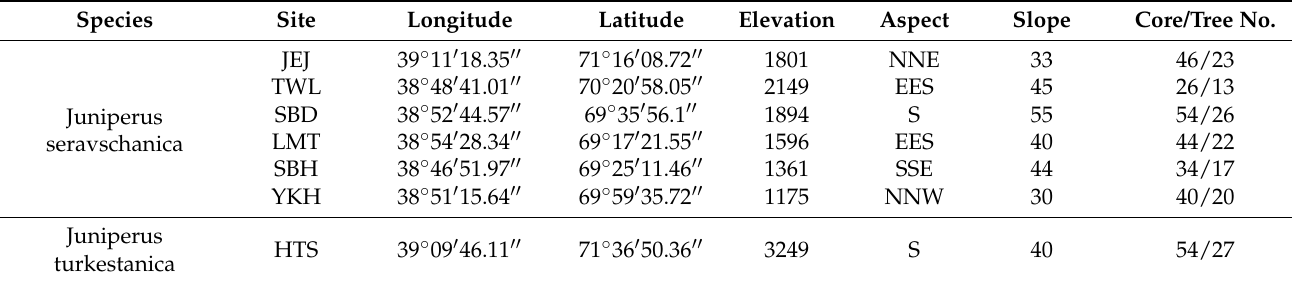
Table 1. Information for juniper (Tajikistan) sampling sites of in Central